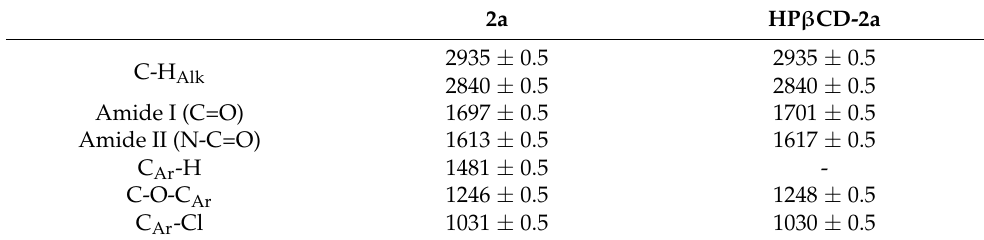
Table 2. Peaks in FTIR spectra of 2a and HP β CD- 2a , cm − 1 .